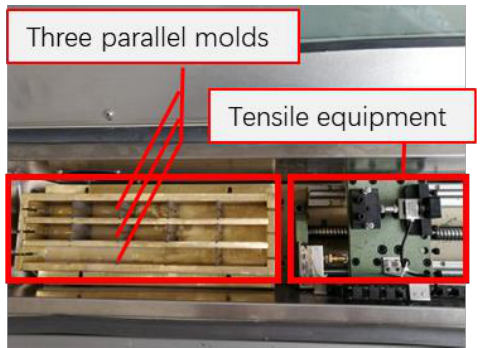
Figure 2. Internal structure of test machine (vertical view).